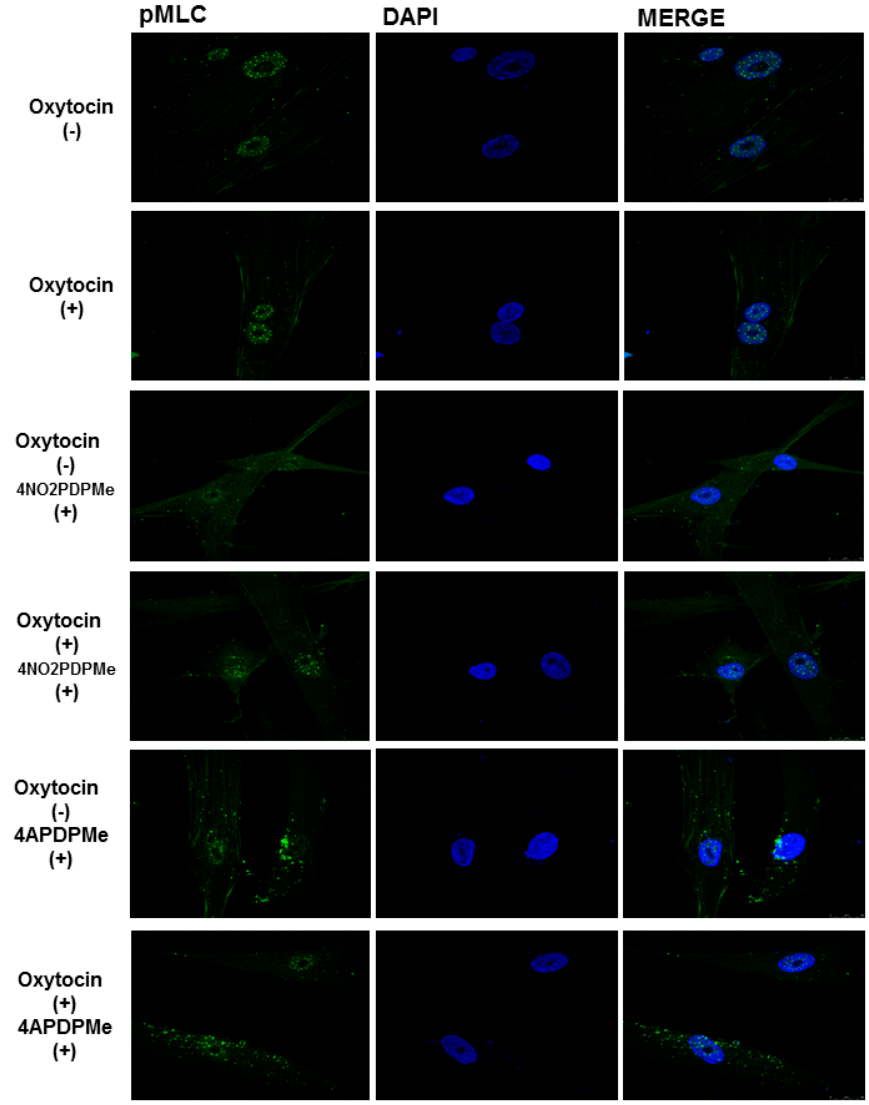
Figure 6. The effects of thalidomide analogs on OT-induced pMLC production in UtSMC cells. Basal pMLC production was faintly increased by OT addition (10 mIU/mL); this rise was augmented in the cytoplasm/cytoskeleton. Previous exposure of the cells to thalidomide analogs (1 mM) caused changes in either basal or OT-induced pMLC subcellular localization. DAPI: 4 ′ ,6-diamidino-2-phenylindole was used to stain the nucleus (blue).